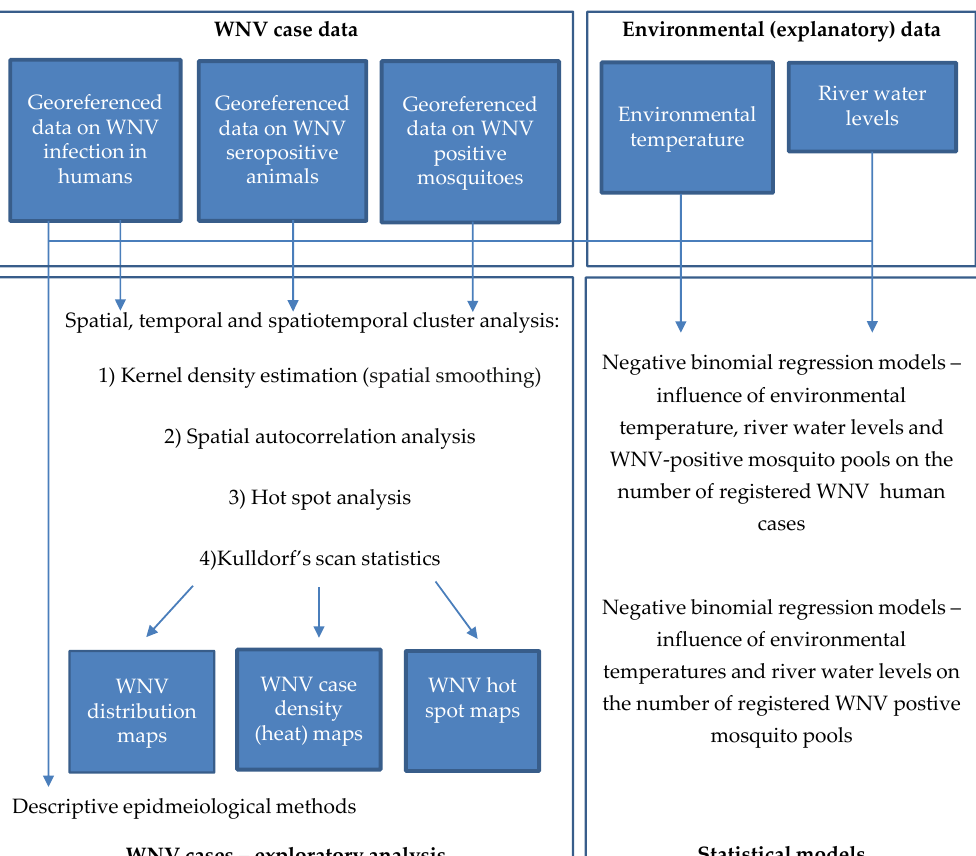
Spatial, temporal and spatiotemporal cluster analysis: